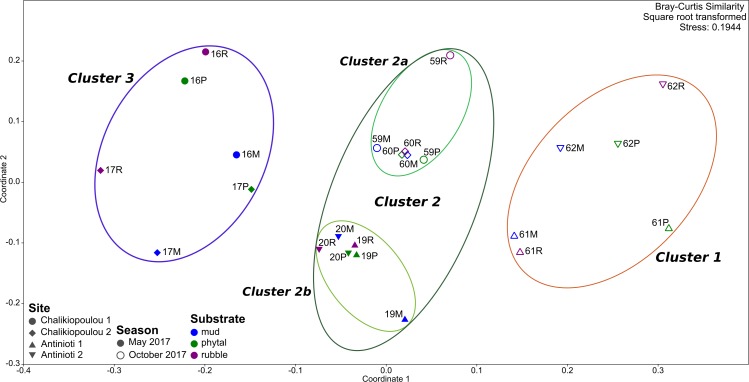
Experimental assemblages (combined replicates) analyzed in an nMDS plot.Superimposed on results are Clusters 1–3 of Fig 2.